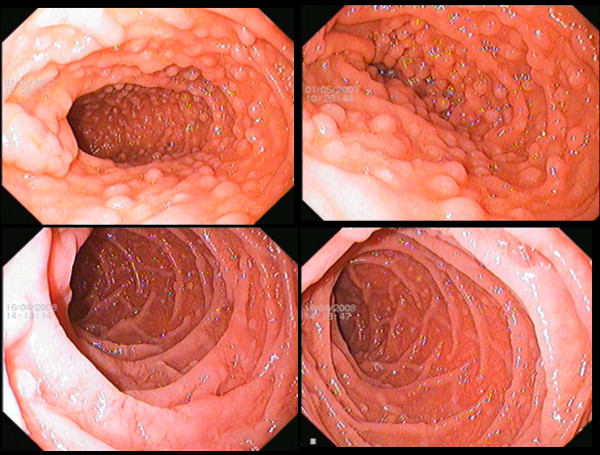
Diffuse Duodenal Nodular Lymphoid Hyperplasia. Duodenal composite images showing effect of H. pylori eradication. 25 year woman presented with recurrent epigastric pain, vomiting and weight loss of 10 kg over past 2 years. Immunoglobulin levels were within normal limits [IgG 1460 mg/dl (normal 700-1600 mg/dl); IgM. 190 mg/dl (normal = 40-230 mg/dl); IgA 230 mg/dl (normal = 70-400 mg/dl)]. Patient had H. pylori infection with severe fundic exudative gastritis. Top 2 images: Second part of duodenum was carpeted with numerous nodular lesions 3 to 5 mm in size, scored as grade 3 nodular disease. Patient received H. pylori sequential therapy and 14C UBT 6 weeks after therapy showed eradication of infection. Bottom 2 images. Follow up duodenoscopic images at one year showed near complete resolution of the nodular lesions (scored as grade 0). Repeat duodenal biopsies failed to show nodular lymphoid follicles.